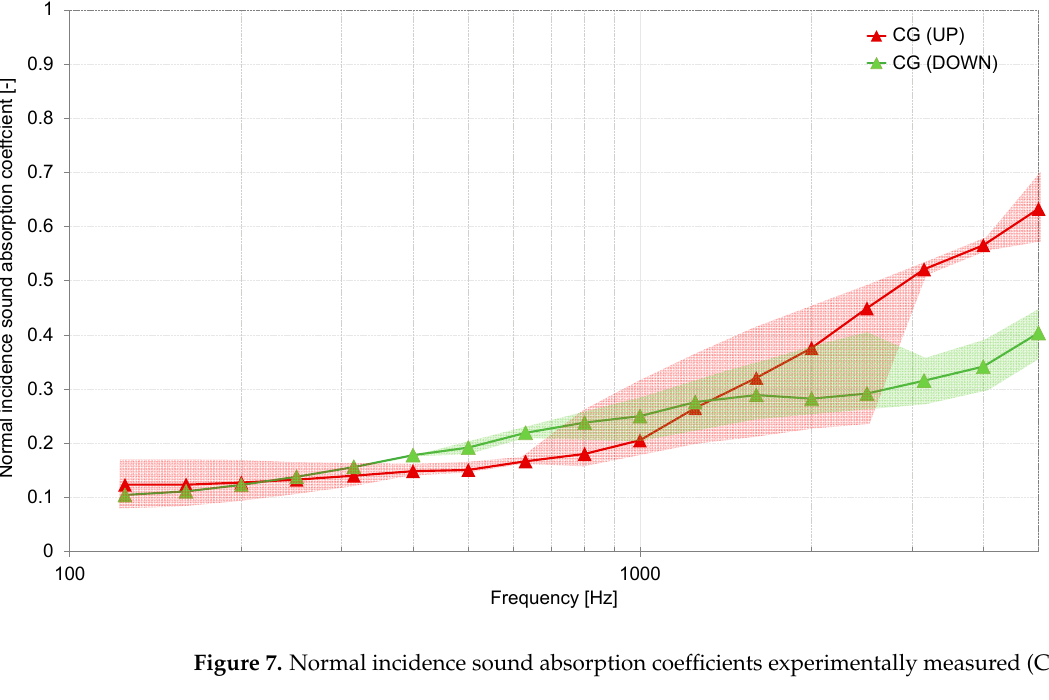
Figure 7. Normal incidence sound absorption coefficients experimentally measured (CG mix).